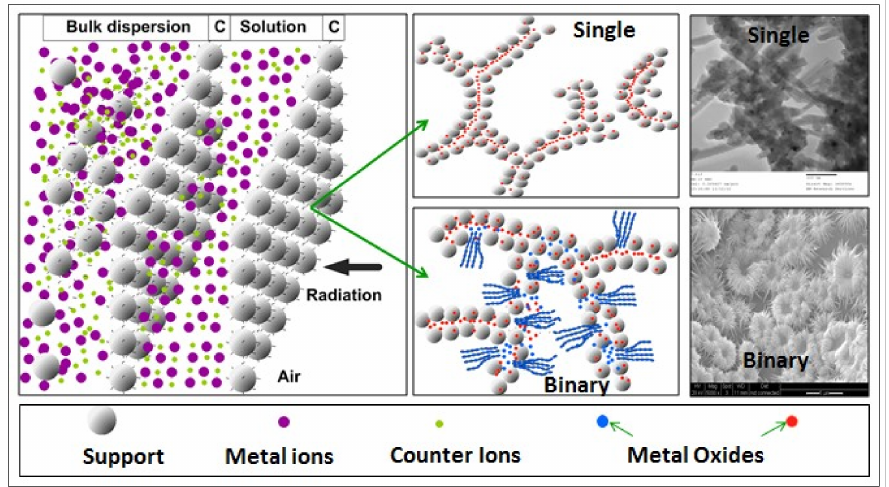
Figure 38. Diagrammatic illustration of the mechanism of radiation induced co-assembled supported single- or binary catalysts. The e ff ect of radiation (including UV-radiation) is to create self-assembled lamellar domains (stage-1) followed by the evaporation of water from the bilayers and immobilization of the support / catalyst bilayers (stage-2) forming catalyst bilayer strands, which then assemble randomly to form the final catalyst structure (stage-3). The structure of supported binary catalysts is di ff erent from that of the single catalyst if there is phase separation between the co-catalysts or between the catalyst and support, resulting in surface